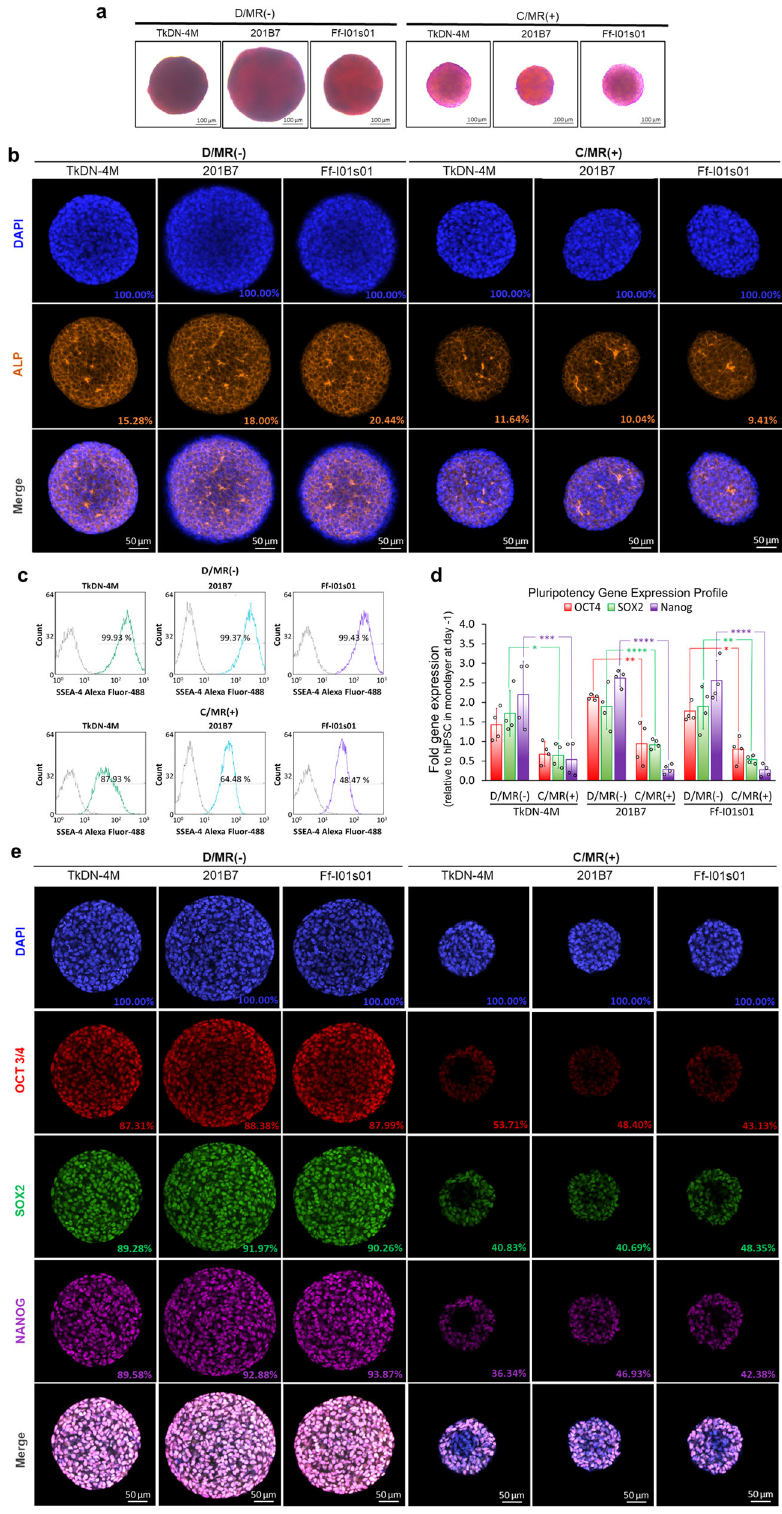
Methods Dialysis device for high-density suspension culture . The dialysis-culture sys- tem included upper and lower dialysate compartments (Fig. 1a). A 40-µm mesh bottom-cell strainer (PluriSelect, Leipzig, Germany) was used as the upper culture compartment, with this insert modi fi ed by cutting and removing the bottom mesh layer. To selectively permeate nutrition or waste products, we af fi xed a 12-kDa MWCO Spectra/Por 4 dialysis membrane (Spectrum Chemical, New Brunswick, NJ, USA) to the bottom side of the strainer using